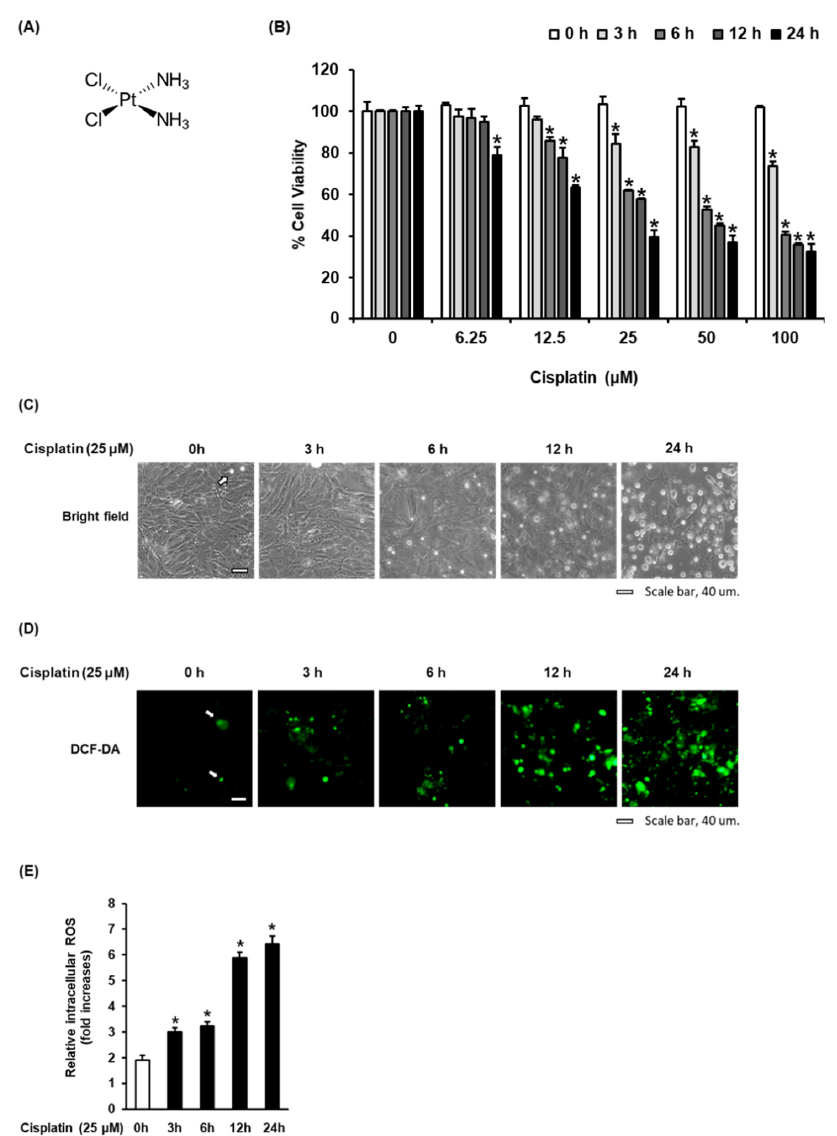
Figure 1. Time-dependent cisplatin-induced oxidative stress in LLC-PK1 cells. ( A ) Chemical structure of cisplatin. ( B ) Cell viability as determined using the Ez-Cytox assay after treatment with 25 M cisplatin for 3, 6, 12, and 24 h. ( C ) Representative images obtained using an IX50 fluorescent microscope. The white arrows indicate dead cells (scale bar = 40 µ M). ( D ) LLC-PK1 cells were treated with 25 M cisplatin for 3, 6, 12, and 24 h, and stained with H2DCFDA. Representative fluorescent images obtained using an IX50 fluorescent microscope. The white arrows indicate intracellular ROS (scale bar = 40 µ M). ( E ) The fold-increases in intracellular ROS levels are represented as a bar graph. Control cells were treated with the vehicle only (mean ± SD, * p < 0.05 compared to the